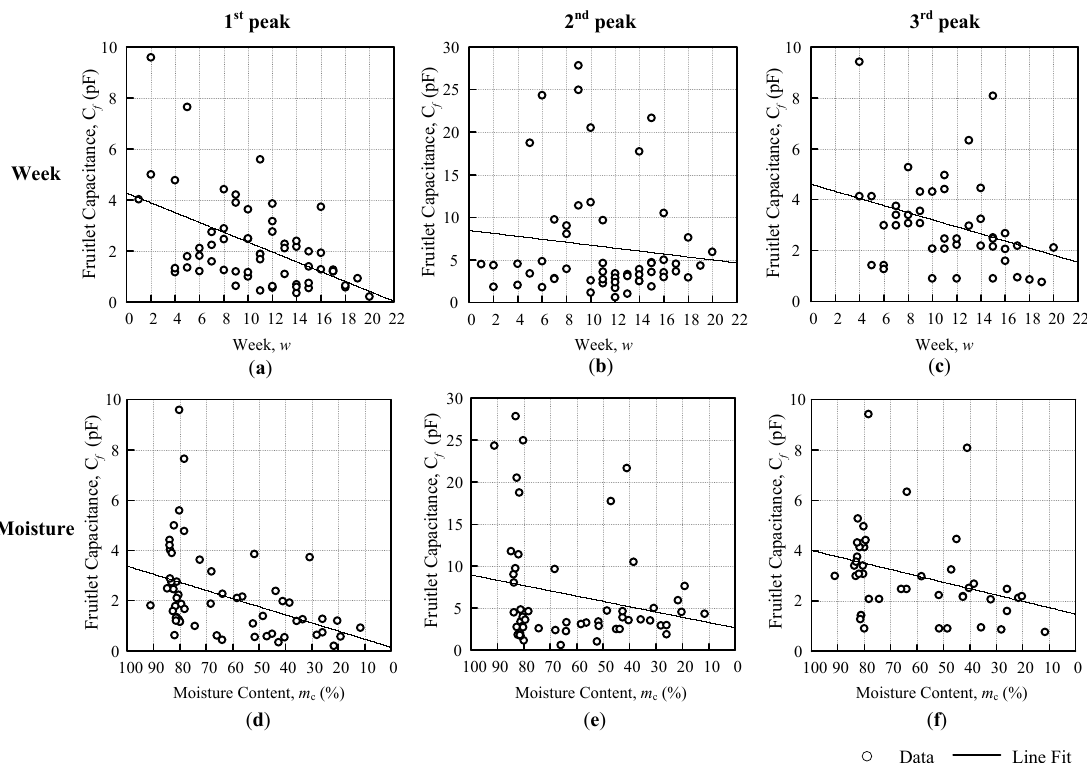
Figure 14. Triple I first, second, and third fruitlet capacitance against the weeks ( a – c ) and moisture content ( d – f ).